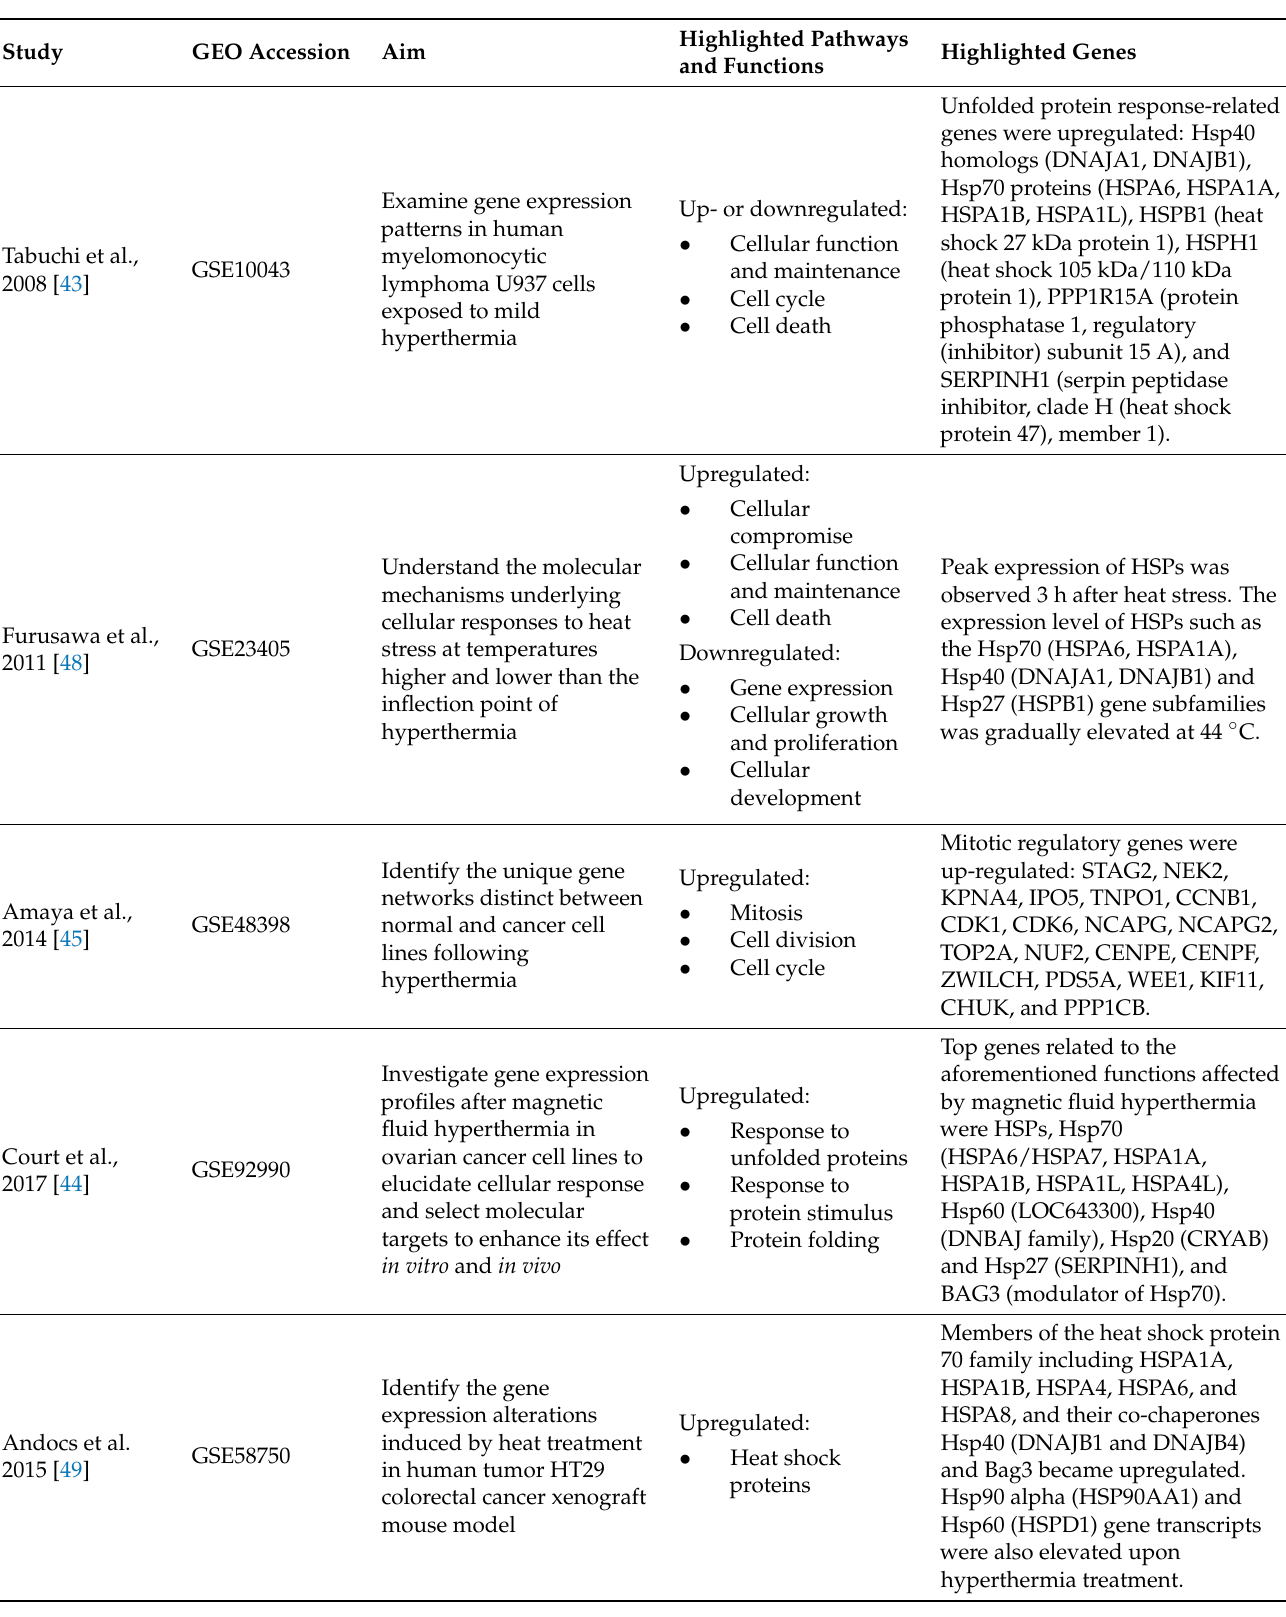
Table 1. Comparison of important pathways and regulated genes between